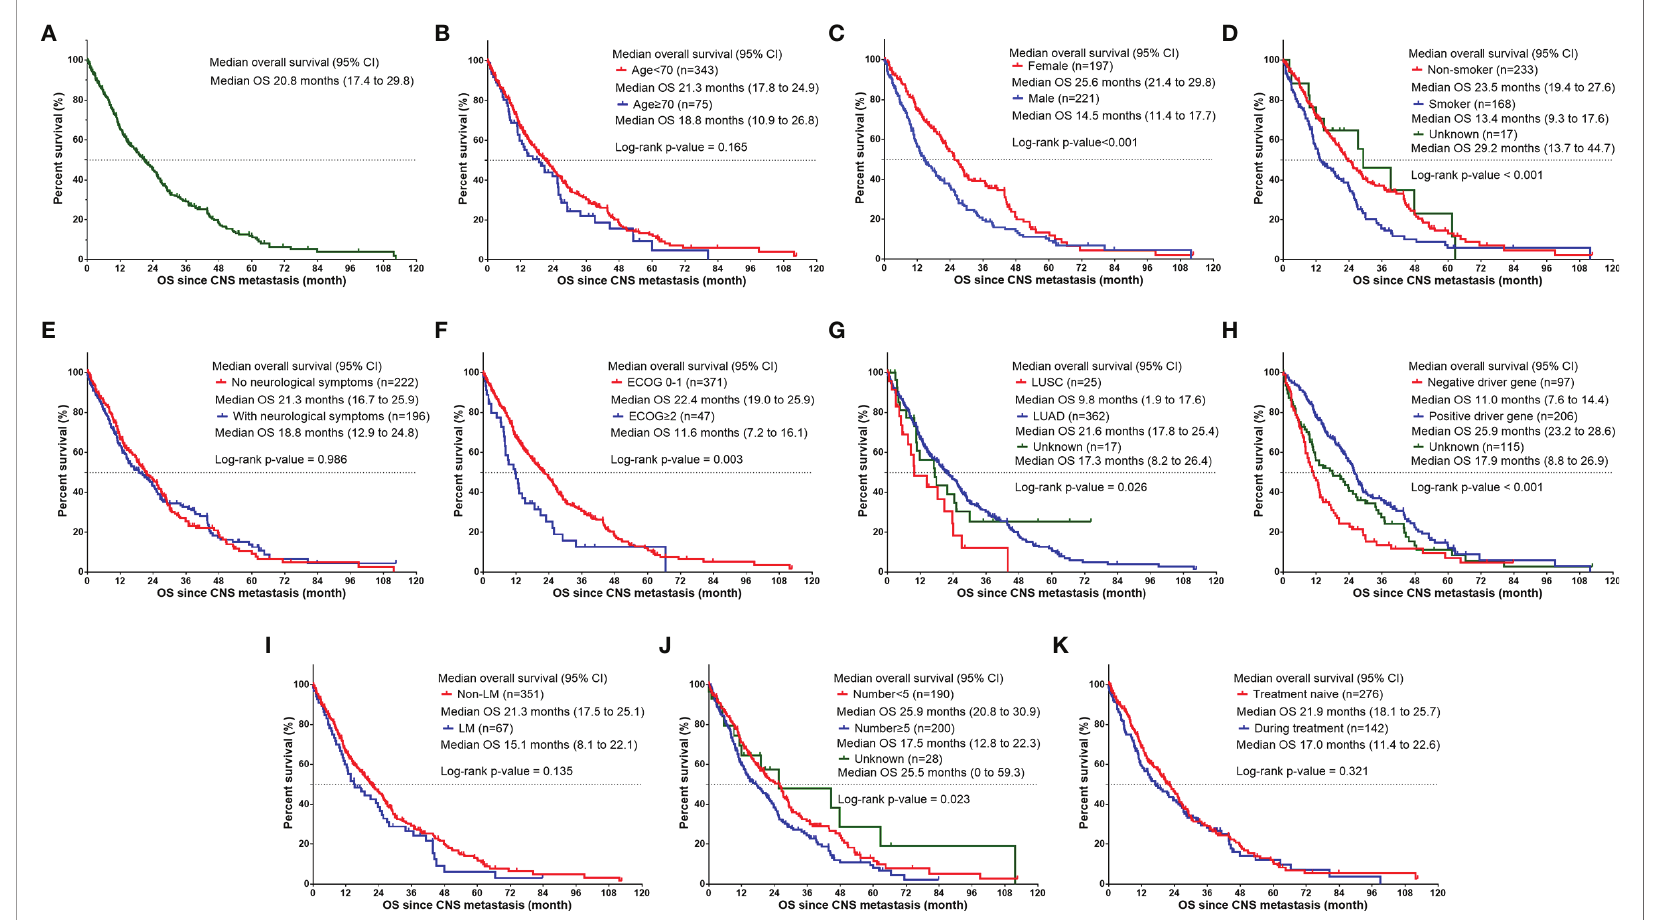
FIGURE 1 | Kaplan – Meier curve showing OS since CNS metastasis developed based on different factors for NSCLC patients. (A) The median OS of NSCLC patients with CNS metastasis. The median OS since CNS metastasis developed (B) in NSCLC patients of age < 70 group vs. age ≥ 70 group, (C) in female patients vs. male patients, (D) in NSCLC patients with different smoking status (non-smoker, smoker, and unknown), (E) in NSCLC patients without neurological symptoms vs. with neurological symptoms, (F) in NSCLC patients of ECOG 0-1 vs. ECOG ≥ 2, (G) in NSCLC patients of different histology subtype (LUSC, LUAD and unknown), (H) in NSCLC patients with different driver gene status (negative driver gene, positive driver gene, and unknown), (I) in NSCLC patients with non-LM vs. with LM, (J) in NSCLC patients with CNS metastasis number <5 vs. CNS metastasis number ≥ 5 vs. unknown, and (K) in NSCLC patients with CNS metastasis developed during treatment vs. treatment naïve. CNS, central nervous system; ECOG, Eastern Cooperative Oncology Group; LM, leptomeningeal metastasis; LUAD, lung adenocarcinoma; LUSC, squamous cell lung carcinoma; NSCLC, non-small cell lung cancer; OS, overall